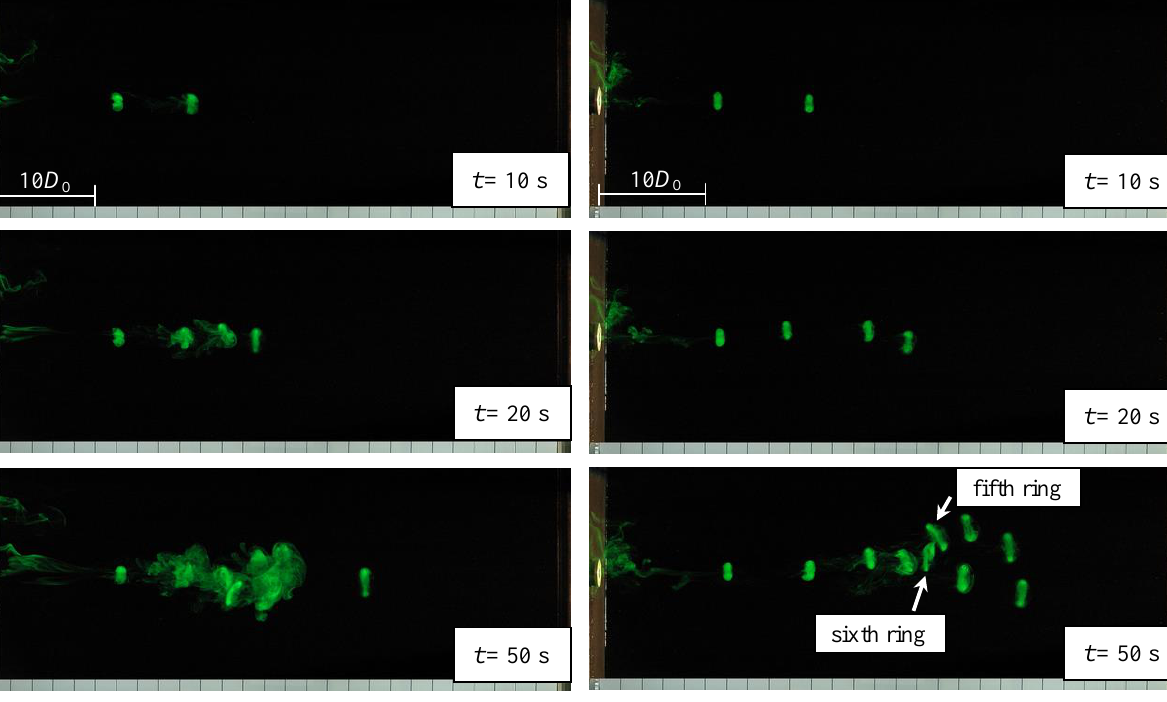
Fig. 2 Successive visualization of vortex rings without swirl in case B.